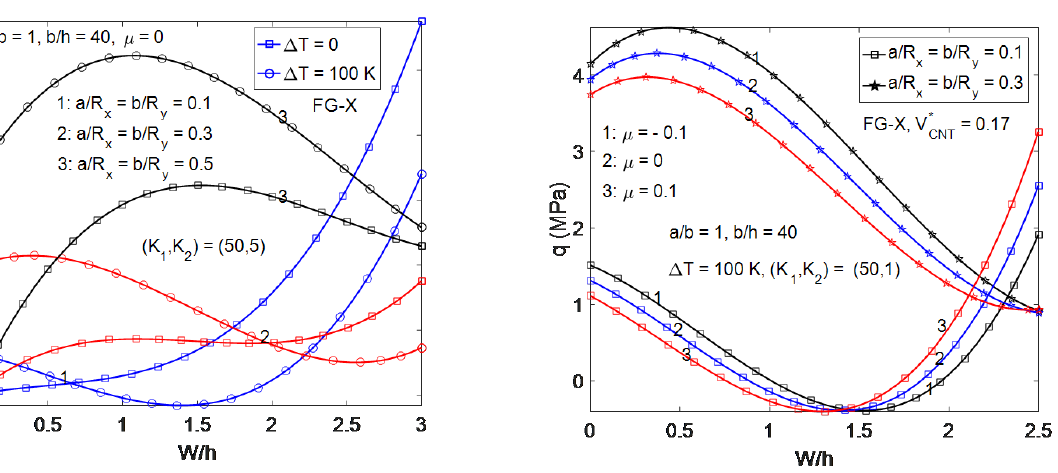
Fig. 16: Effects of imperfection and curvature parameters on the nonlinear thermomechanical response of FG-CNTRC spherical pan- els with immovable